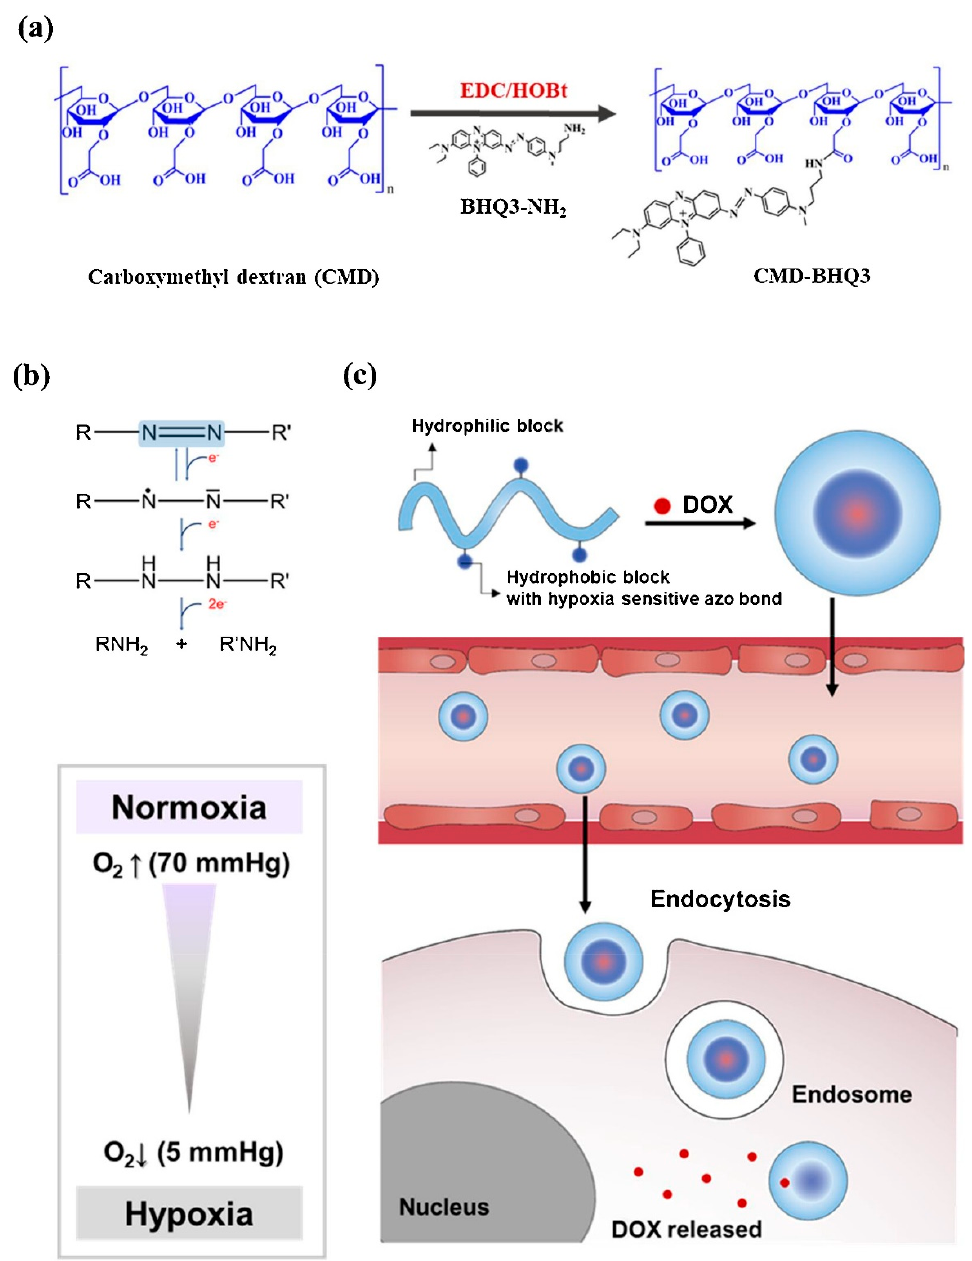
Figure 2. ( a ) Schematic formation of the hypoxia-sensitive amphiphilic polymer complex. ( b ) Reduction of azobenzene derivatives. ( c ) Schematic demonstration of the DOX-loaded CMD-BHQ3 NPs (DOX@CMD-BHQ3 NPs) and their hypoxia-responsive release behavior. DOX@CMD-BHQ3 NPs accumulate in the tumor environment due to the EPR effect, and the drug release occurs under hypoxic conditions of the intracellular environment. Reprinted from [80].